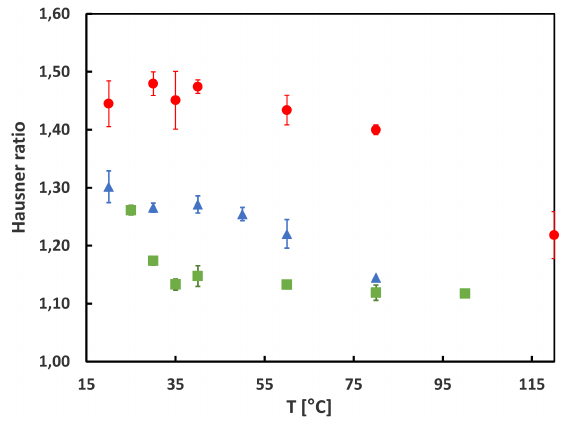
Figure 2. Evolution of the Hausner ratio ( Hr ) as a function of the temperature for lactose powder (red dots), dried milk (blue triangles) and cocoa (green squares). Error bars are ± the stan- dard deviation around the mean computed from three repeatabil- ity tests.